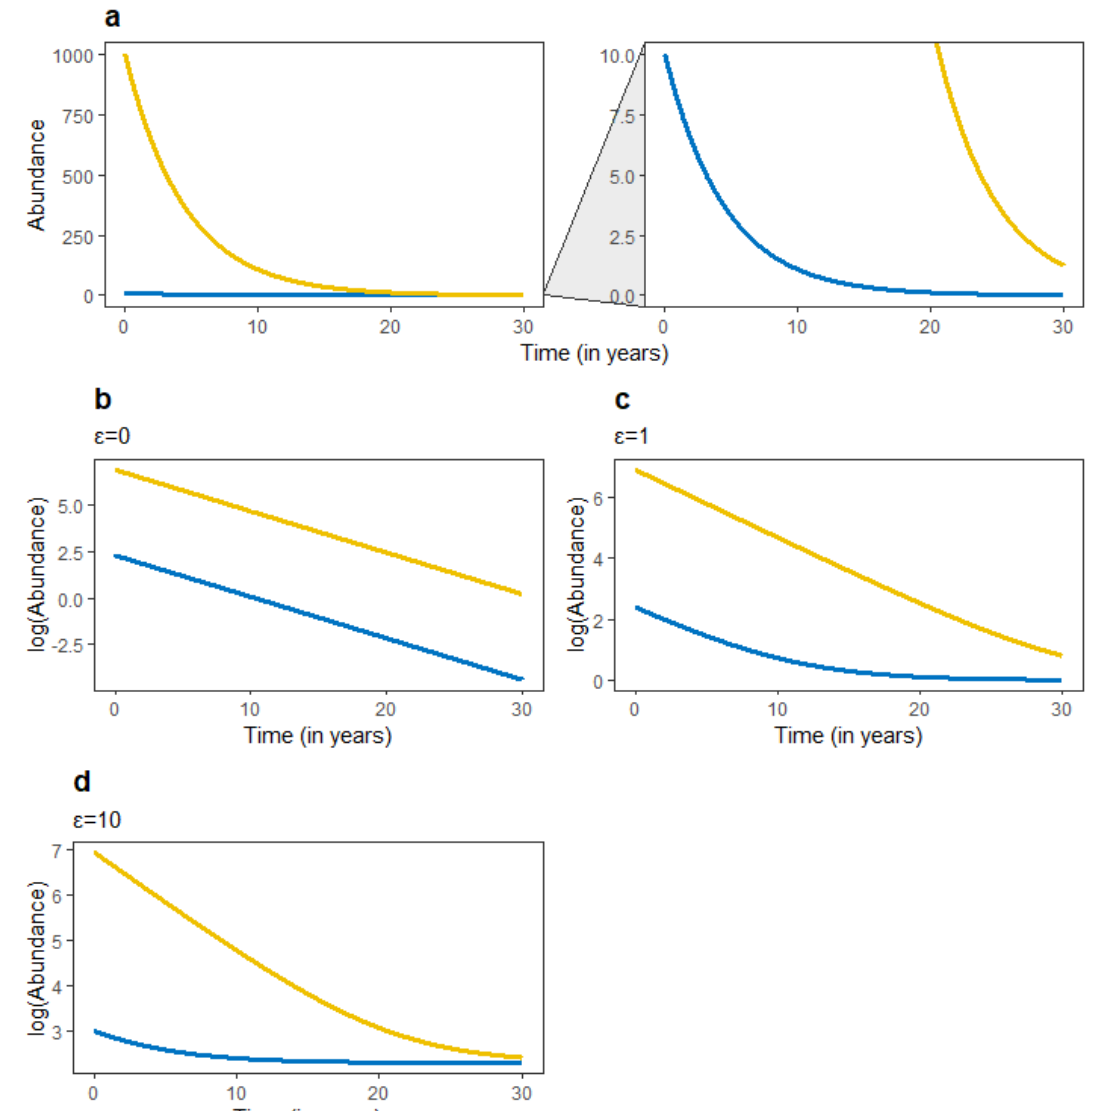
Figure S2: Representation of a geometric decline over time. (a) Abundance, measured as number of individuals, against time, for two species declining with a rate of 20% per year (growth rate = 0.8). Zooming on a part on the bottom of the y-axis, we can see that both species decline with the same rate, but since one is rare and the other is common, variations in number of individuals are much larger for the common species. (b,c,d) represents the same dynamics as in a, but applying the transformation log(x+ε) to the abundance, with three values of